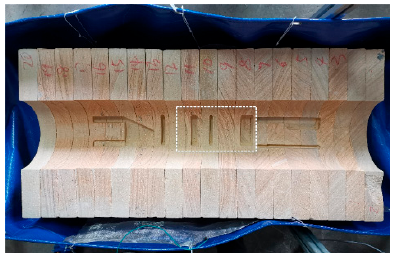
Figure 19. Experimental well.